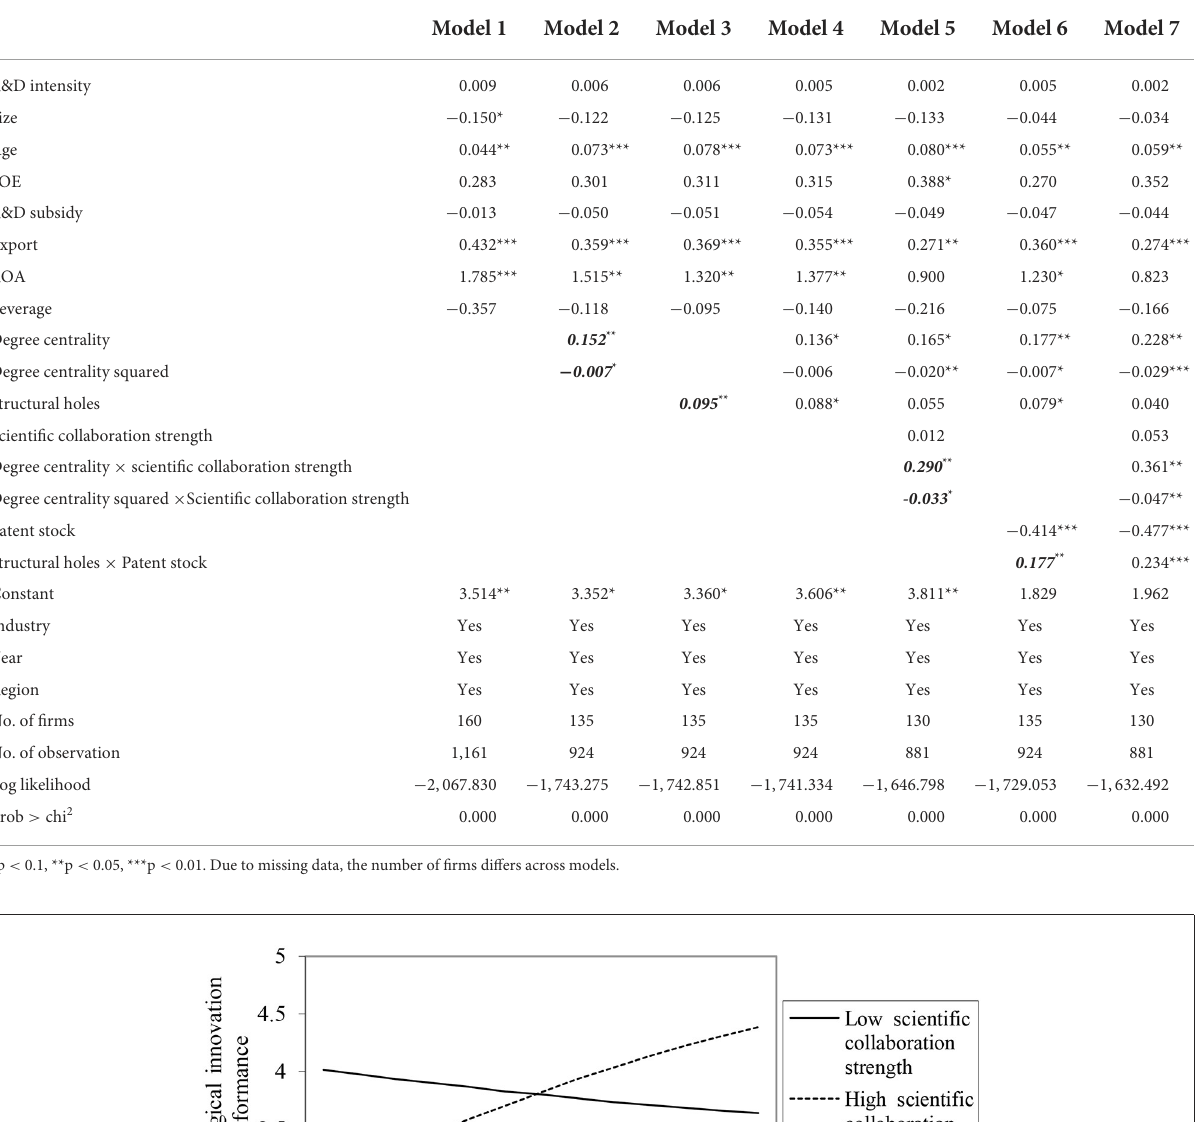
TABLE 2 The negative binomial regression for technological innovation performance.